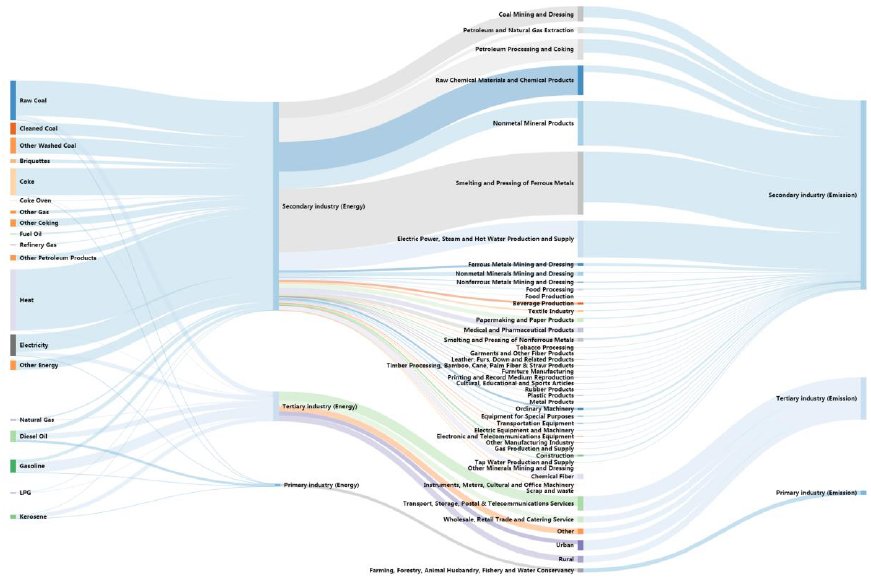
Figure 3. Energy and carbon emission’s circulation map of target cities in Sichuan Province, 2015.